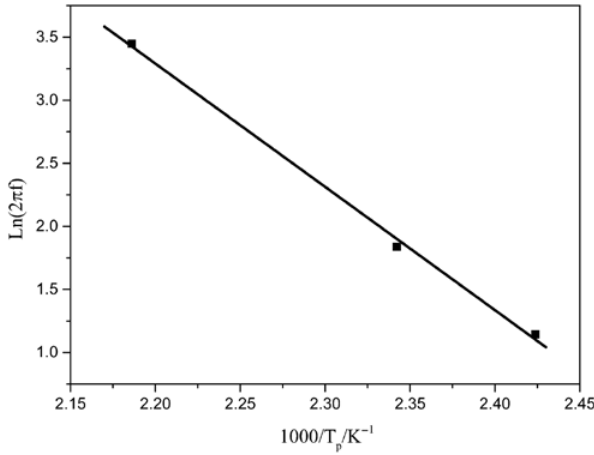
Figure 8: Arrhenius relation between the circle frequency and the peak temperature of 6wt.% FAC/AZ91D composites.